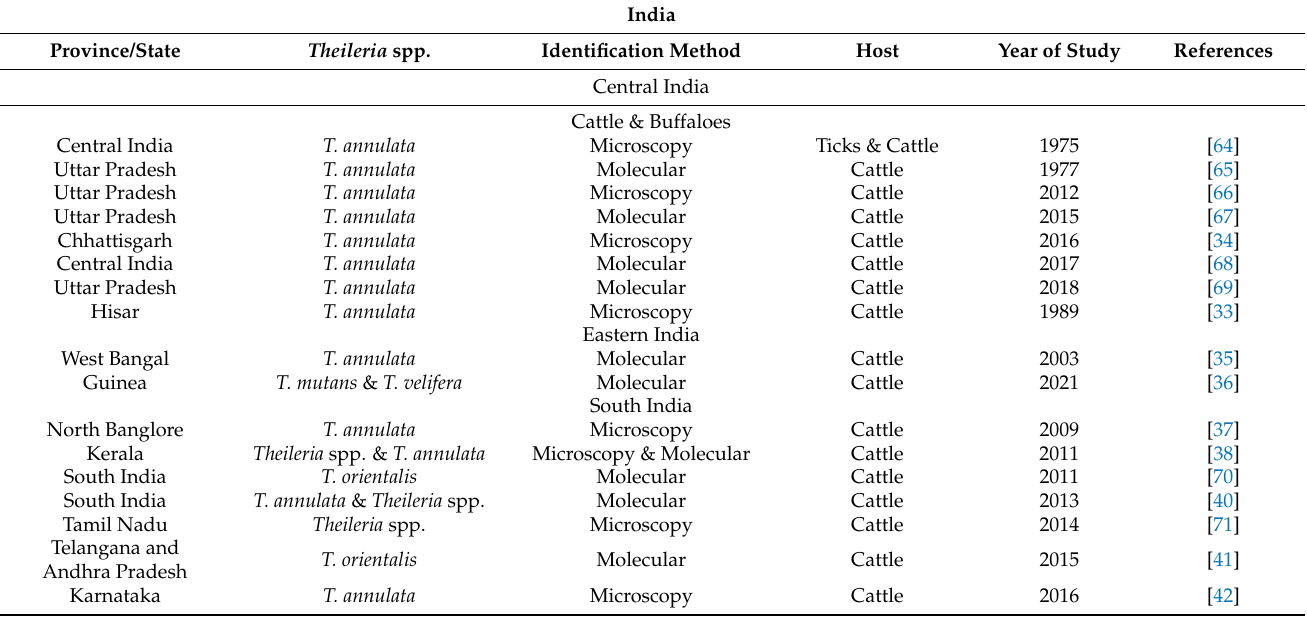
Table 2. Regional wise distribution of Theileria Species in different regions of